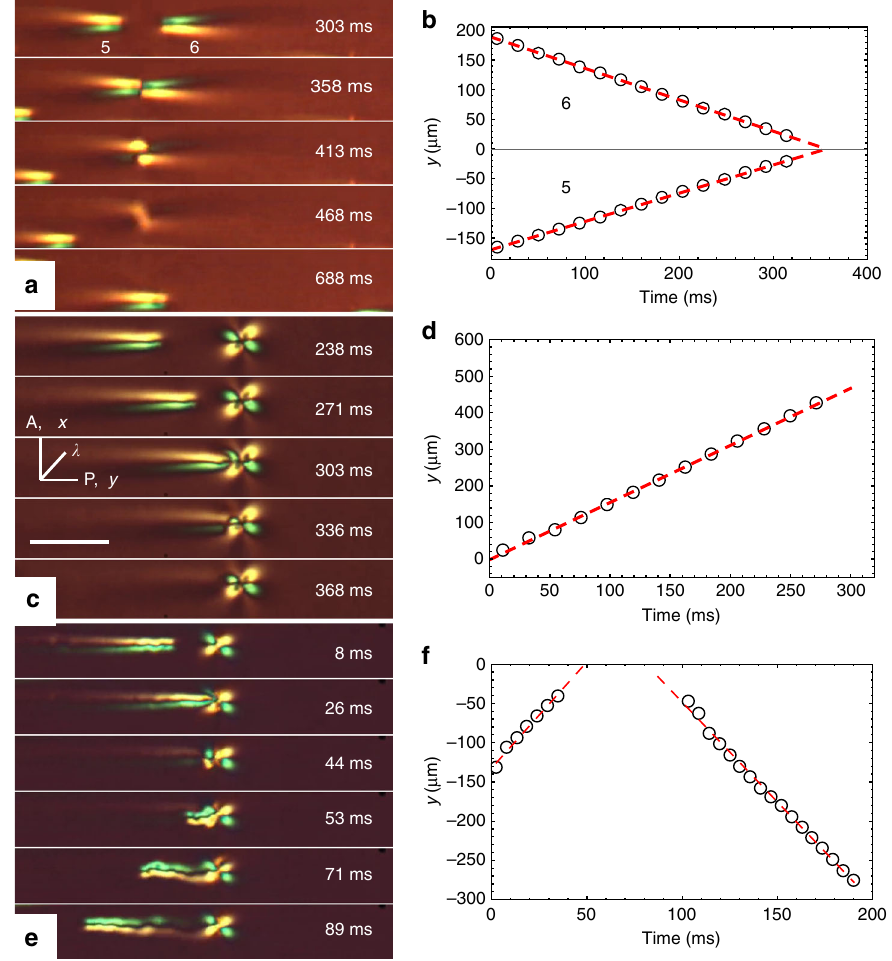
Fig. 9 Scenarios of soliton's interactions with each other and with obstacles. a Polarizing microscopy of time sequence of annihilation of solitons “ 5 ” and “ 6 ” ; U = 45.1 V, f = 600 Hz, T = 50 °C, d = 8.0 μ m. b Locations of annihilating solitons (determined as the coordinate of the maximum of light transmittance) vs. time. c , d Disappearance of a soliton at a dust particle. U = 65.6 V, f = 800 Hz, T = 50 °C, d = 7.7 μ m. Scale bar 100 µ m. e , f Re fl ection of a soliton on a dust particle. U = 87.4 V, f = 1000 Hz, T = 45°C, d = 8.2 µ m. a , c , e present polarizing microscopy textures under crossed polarizers and a compensator, as shown in